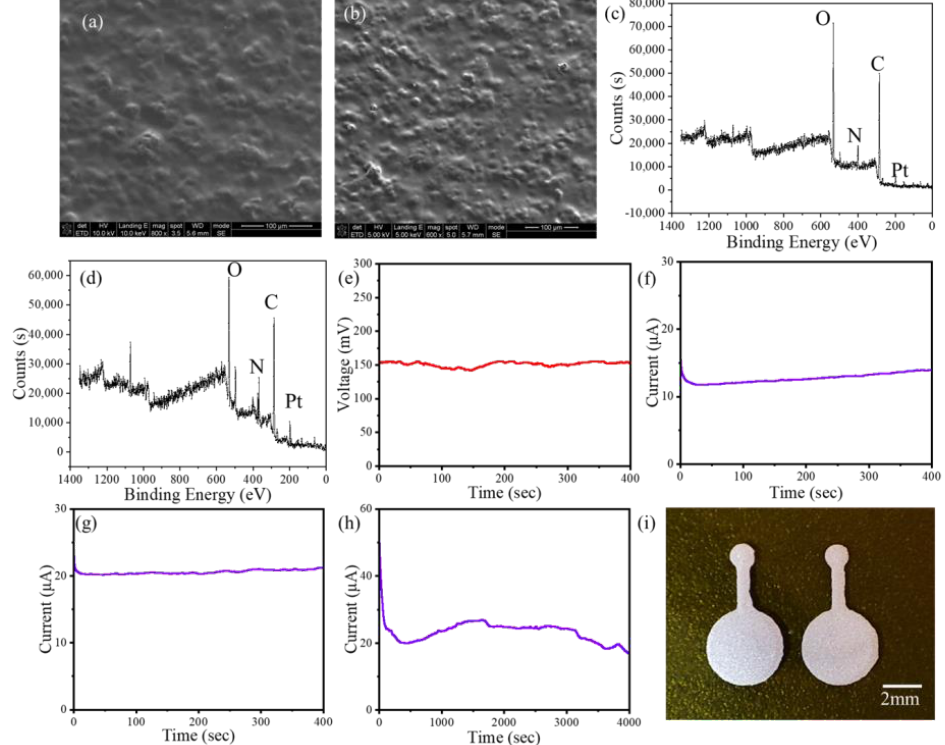
Figure 3. ( a ) SEM image of the anode. ( b ) SEM image of the cathode. ( c ) XPS image of the anode. ( d ) XPS image of the cathode. ( e ) Voltage output of the single BFC in 400 s. ( f ) Current output of the single BFC in 400 s. ( g ) Current output of the two BFCs paralleled in 400 s. ( h ) Current output of the two BFCs paralleled in 4000 s. ( i ) Photo of the electrode.